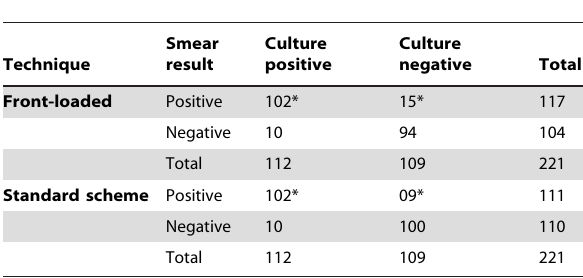
Table 2. Performance of frontloading and WHO